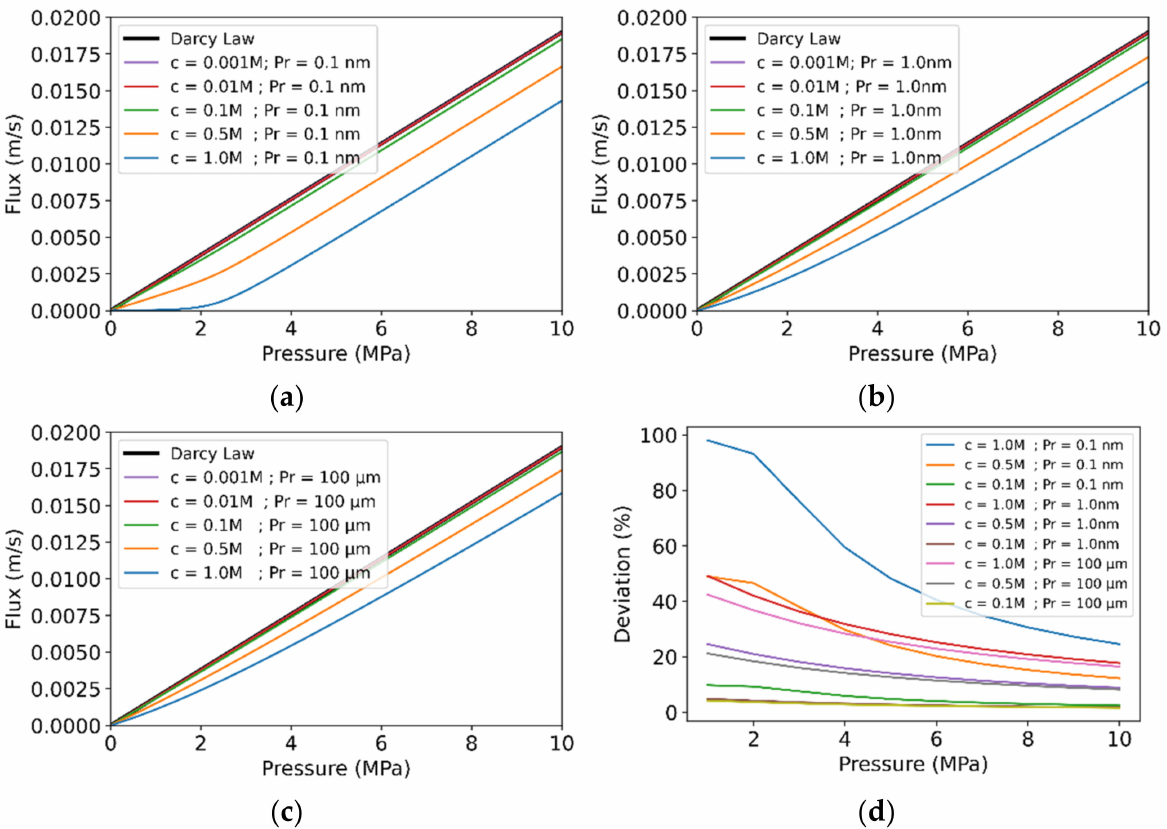
Figure 6. Effect of reverse osmosis on the resultant flow velocity at different solution concentrations and pore radii. c is the bulk concentration, expressed in molarity (M); Pr is the pore radius of zone B. ( a ) Pore radius = 0.1 nm, ( b ) pore radius = 1.0 nm, ( c ) pore radius = 100 µ m, ( d ) percentage deviation of simulated results from the Darcy law.